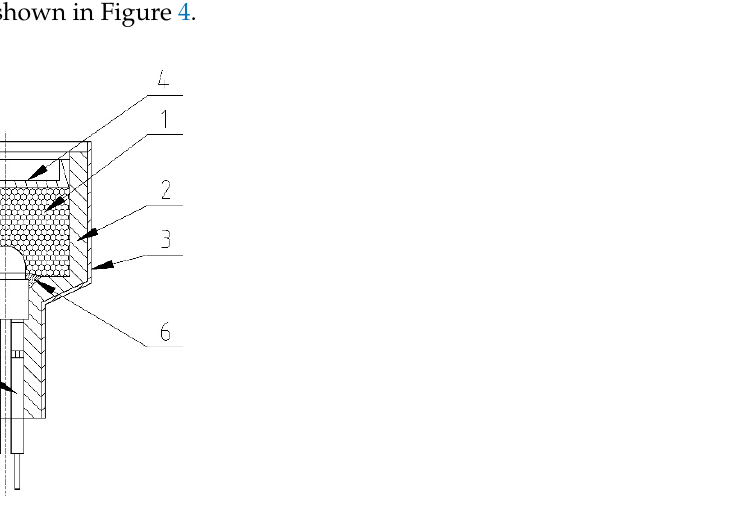
Figure 4. Cross section of commercially available igniter (redrawn according to patent application